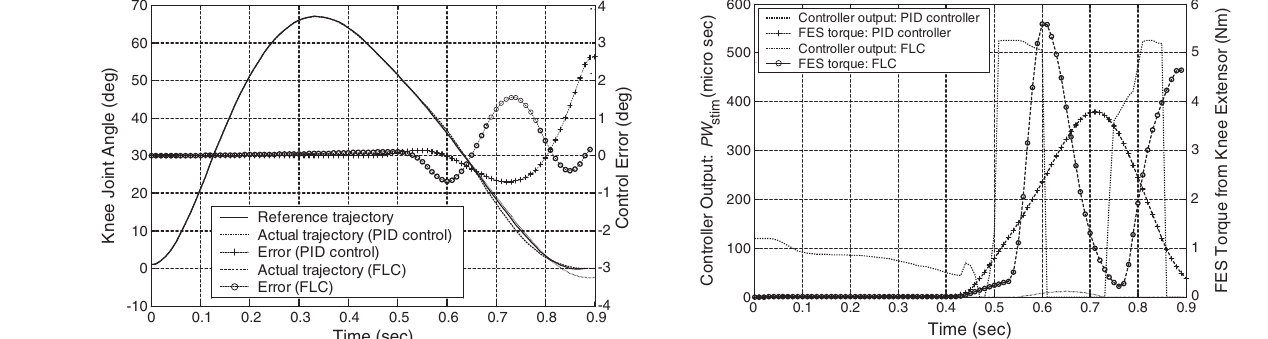
proportional- and derivative input and for the output were 0.42132, 0.74246 and 680.94 respectively.